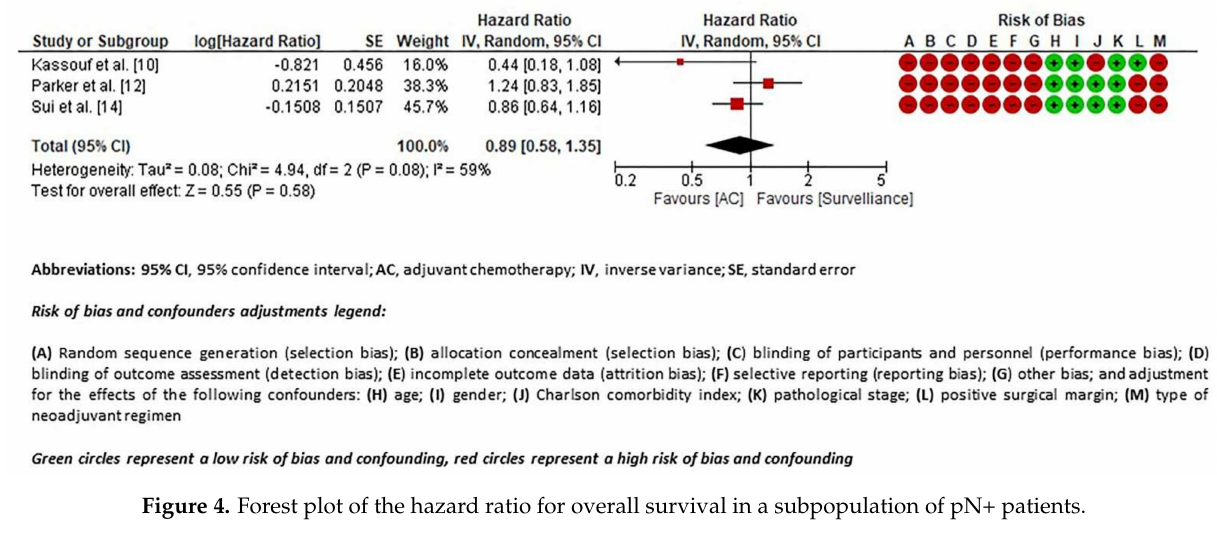
Figure 4. Forest plot of the hazard ratio for overall survival in a subpopulation of pN+